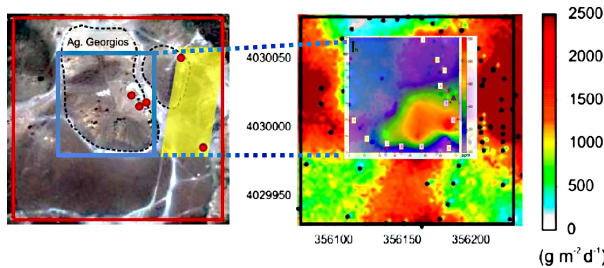
Figure 7. Our TDL CO 2 map for Nea Kameni volcano (same as Fig. 2) compared with the soil CO 2 flux map of Parks et al. (2013). The study of Parks et al. (2013) covered a wider exhaling area that contributes a diffuse CO 2 output of 38 ± 6td − 1 (in January 2012), or ∼ 60% of our 63 ± 22td − 1 fumarolic CO 2 output. Left, (mod- ified from Parks et al., 2013): red square: survey area investigated from Parks et al. (2013); blue square: our survey area; red dots: po- sition of fumaroles (from Tassi et al., 2013); yellow box: the area with elevated diffuse degassing (Parks et al., 2013 and Chiodini et al., 1998); black dashed circles: summit